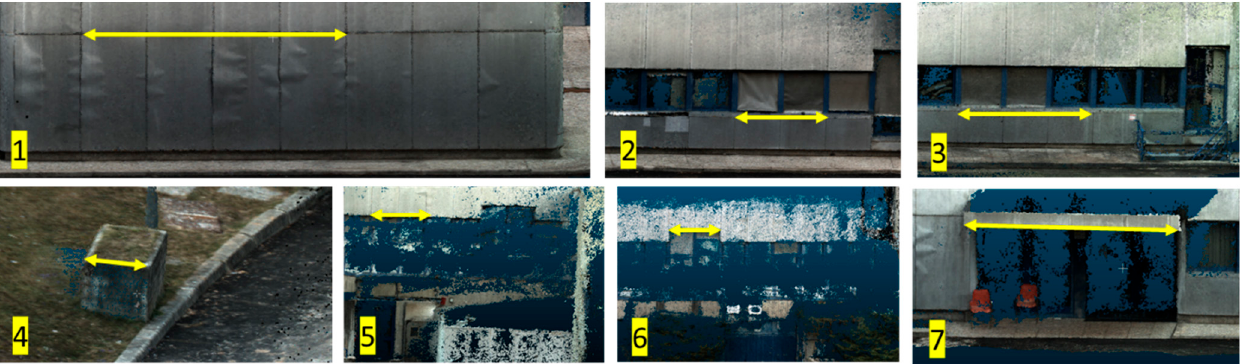
Figure 13. Segments considered in the LME and RLME analyses (Table 3). Table 3. Measured lengths, LME and RLME between the selected segments (Figure 13).